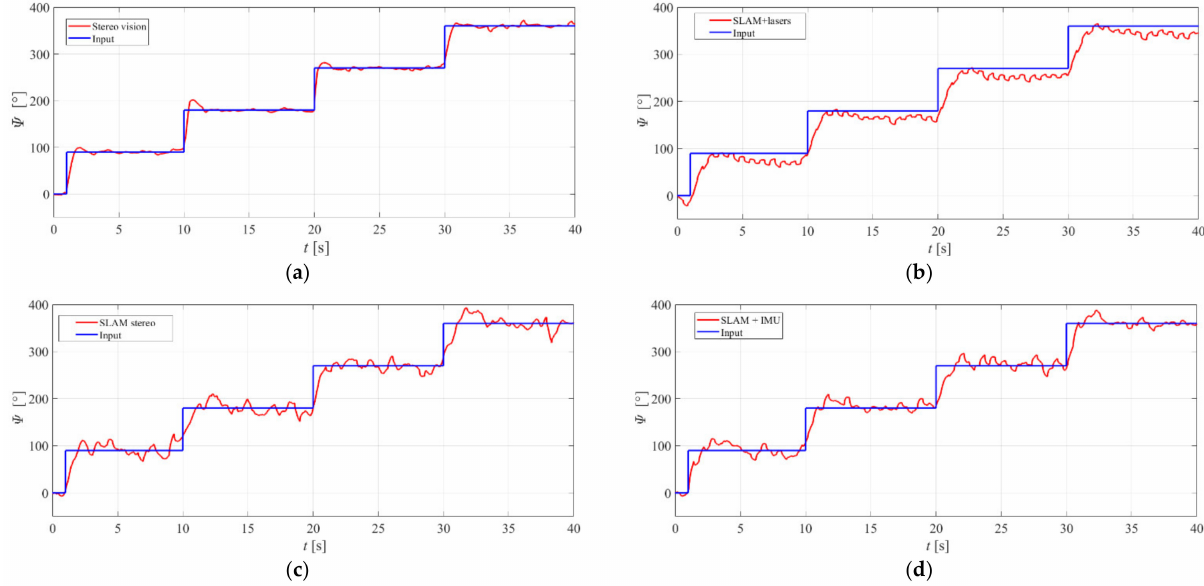
Figure 15. Heading control for velocity equals 0.1 m/s: ( a ) stereo vision; ( b ) SLAM lasers; ( c ) SLAM stereo; ( d ) SLAM